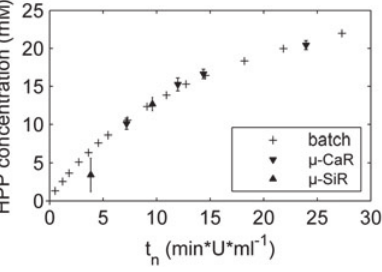
Figure 10 HPP concentration in the course of the reaction. Reaction